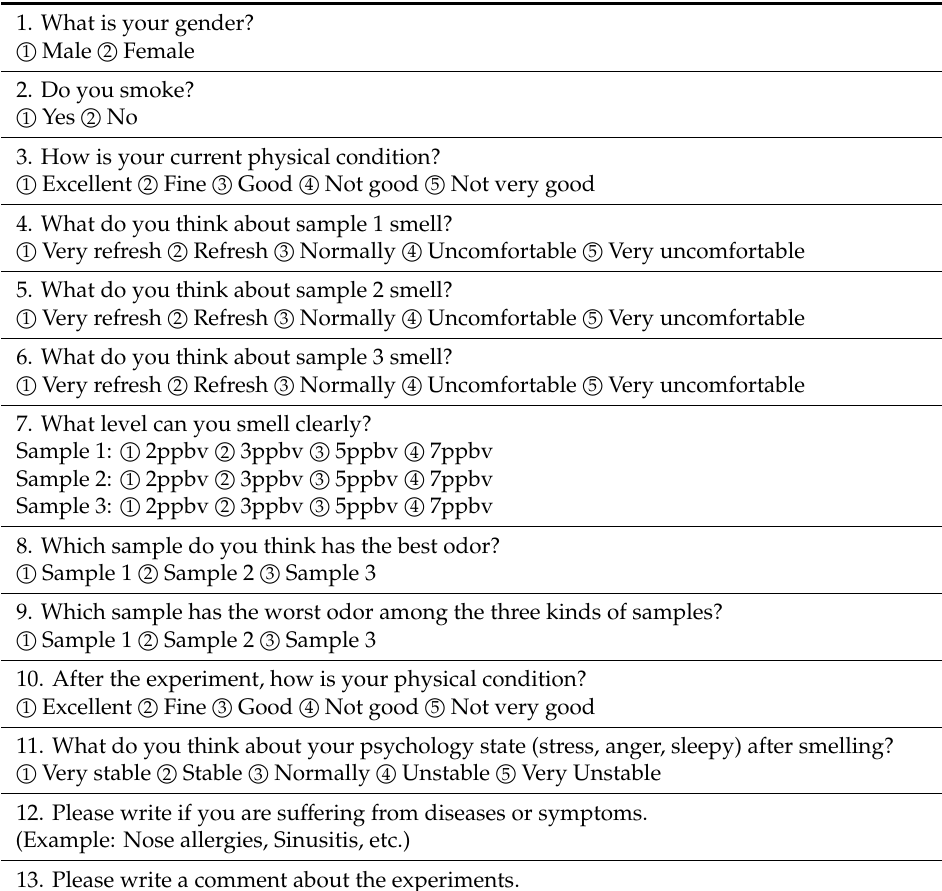
Table 2. Questionnaire for the assessment of human responses to the odors of α - pinene, β - pinene, d -